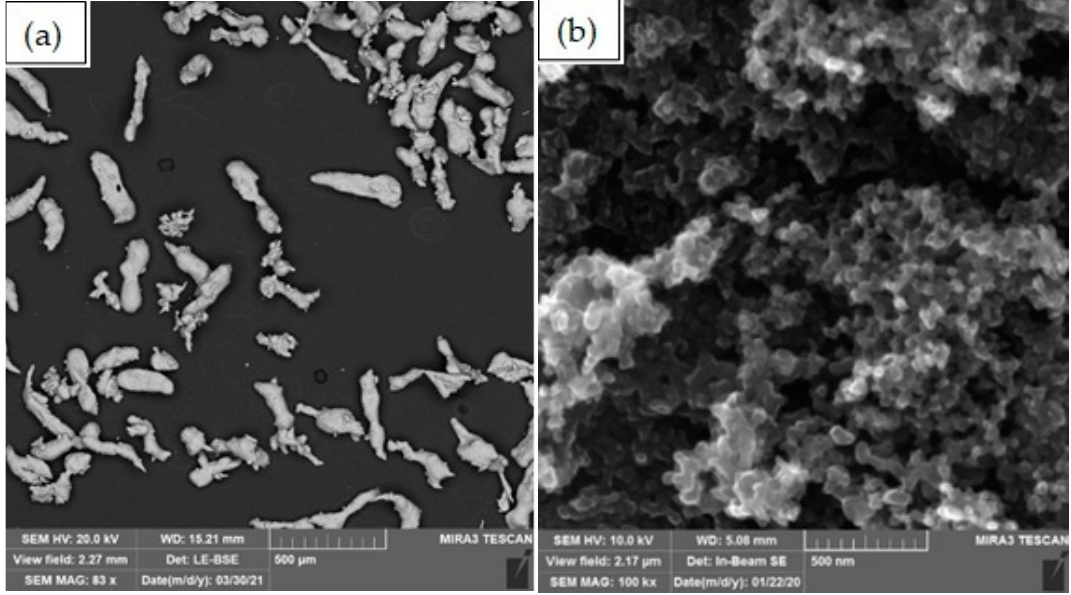
Figure 1. SEM images of pure materials: ( a ) aluminum, ( b ) fullerene soot. Ball milling was carried out in a Fritsch Pulverisette 7 premium line ball mill (FRITSCH, Markt Einersheim, Germany) in 80 ml steel containers. Initially, the powders were